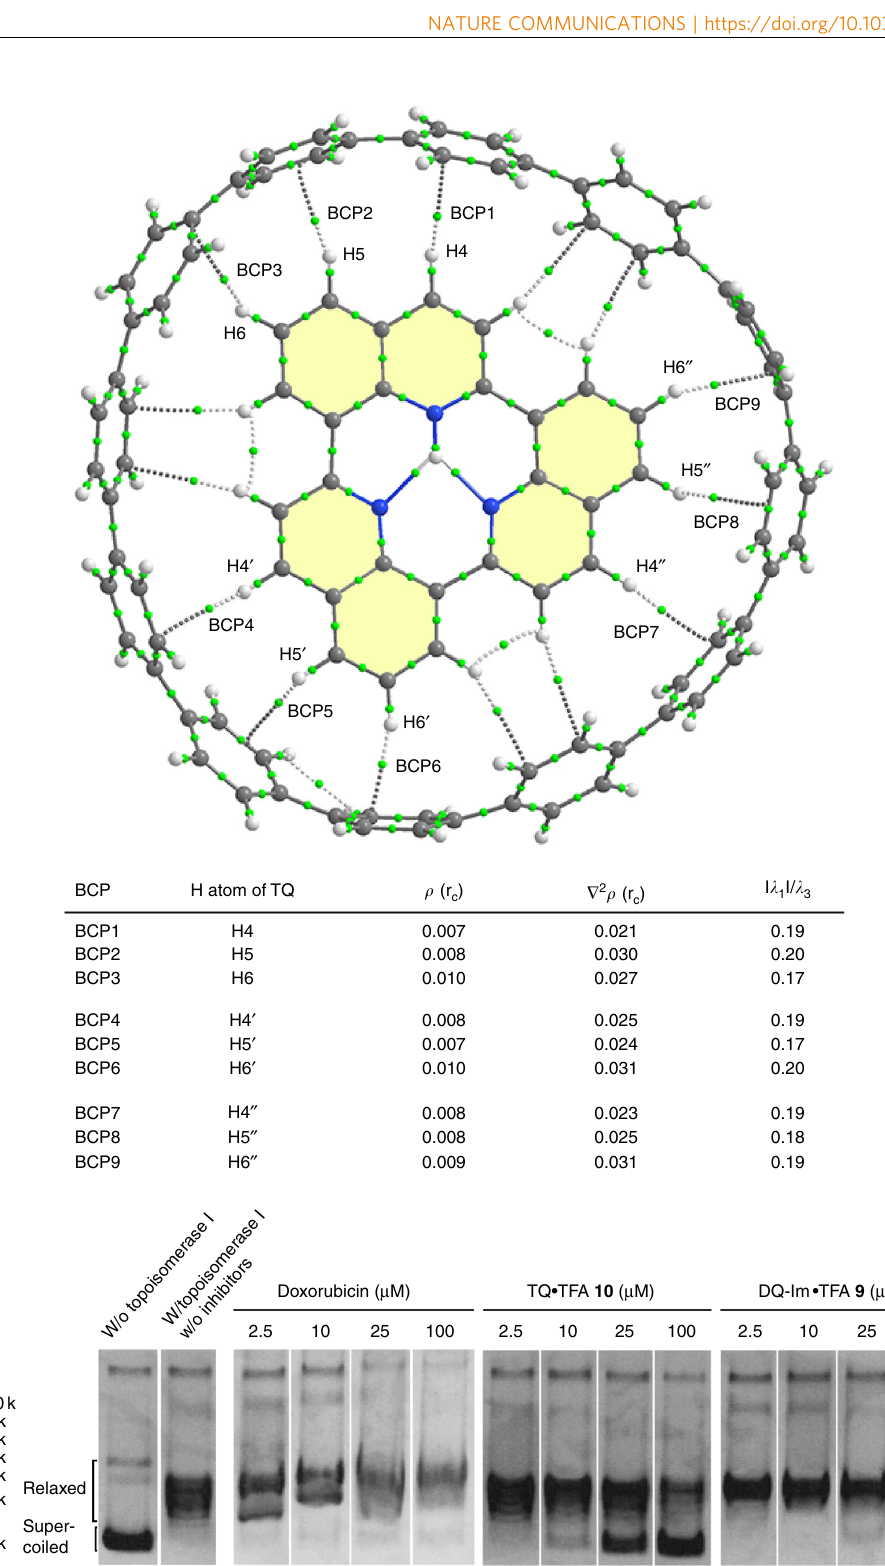
Fig. 6 Non-covalent interactions of TQ. a QTAIM analysis of the optimised structure of the inclusion complex [12]CPP ⊃ TQ (cid:129) H + 15 . The [3, – 1] bond critical points (BCPs) are shown as green circles on the bonds. The key parameters of the nine intermolecular BCPs that satisfy the criteria for CH – π interactions are shown: the electron density ρ ( r c ), the Laplacian of the electron density ( ∇ 2 ρ ( r c )), and the ratio of the curvature of the density at the BCP (| λ 1 |/ λ 3 ). b Intercalation assays with topoisomerase I. Supercoiled DNA exhibits higher mobility (downward) in the gel. Doxorubicin and TQ (cid:129) TFA 10 inhibit the relaxation of plasmid DNA induced by topoisomerase I in a concentration-dependent manner, while DQ-Im (cid:129) TFA 9 exhibits a signi fi cantly weaker inhibitory effect. The uncropped gels are shown in Supplementary Fig.